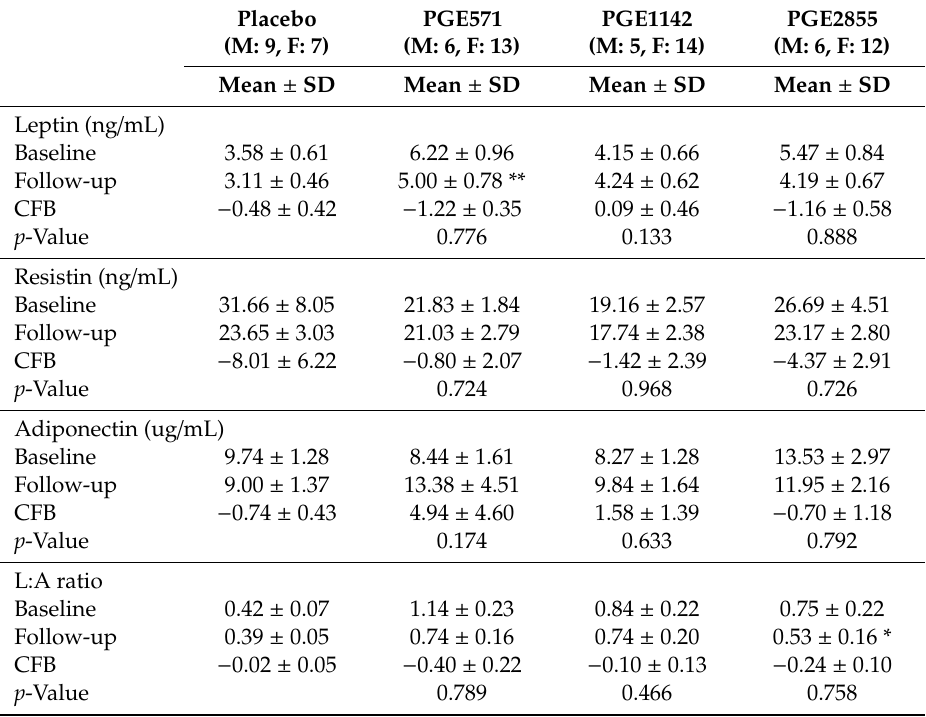
Table 6. E ff ect of supplementation of PGE for 12 weeks on changes of serum adipokine levels in subjects with overweight or